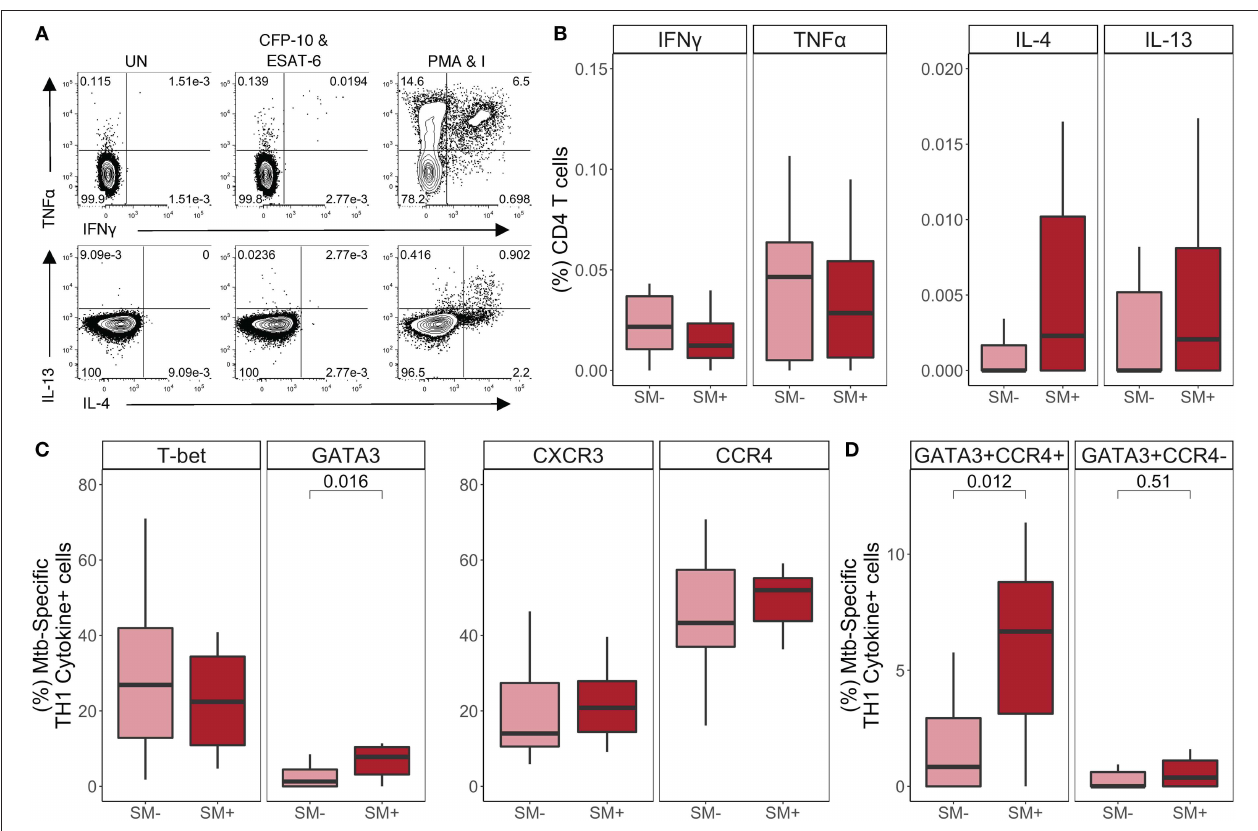
FIGURE 5 | SM + individuals with active TB disease have similar frequencies of TH1 cytokine + Mtb-specific CD4T cells, but higher expression of GATA3 and CCR4, compared with SM − TB patients. PBMC samples obtained from SM + and SM − TB individuals were incubated for 18h in media alone (negative control), PMA and ionomycin (positive control), or CFP-10 and ESAT-6 peptide pools. Intracellular expression of IFN- γ , TNF- α , IL-4, and IL-13 was measured by flow cytometry. (A) Representative flow cytometry data from an SM + patient with active TB disease. Plots are shown gated on live CD3 + CD4 + CD8 − lymphocytes from the unstimulated and stimulated conditions. (B) Frequency of Mtb-specific CD4T cells producing each indicated cytokine (SM − , n = 25; SM + , n = 15). Data are shown after subtraction of background cytokine production in the unstimulated negative control condition. (C,D) Samples meeting the criteria for a positive Mtb-specific TH1 cytokine response (see Materials and Methods) were evaluated for expression of lineage specific transcription factors and chemokine receptors by flow cytometry. The frequency of Mtb-specific TH1 cytokine + CD4T cells expressing the indicated transcription factor and chemokine receptor (C) as well as co-expressing cells (D) are reported (SM − , n = 15; SM + , n = 9). Boxes represent the median and interquartile ranges; whiskers represent the 1.5*IQR. Differences in the frequency of each CD4T cell population between SM + and SM − individuals were assessed using a Mann Whitney U -test.